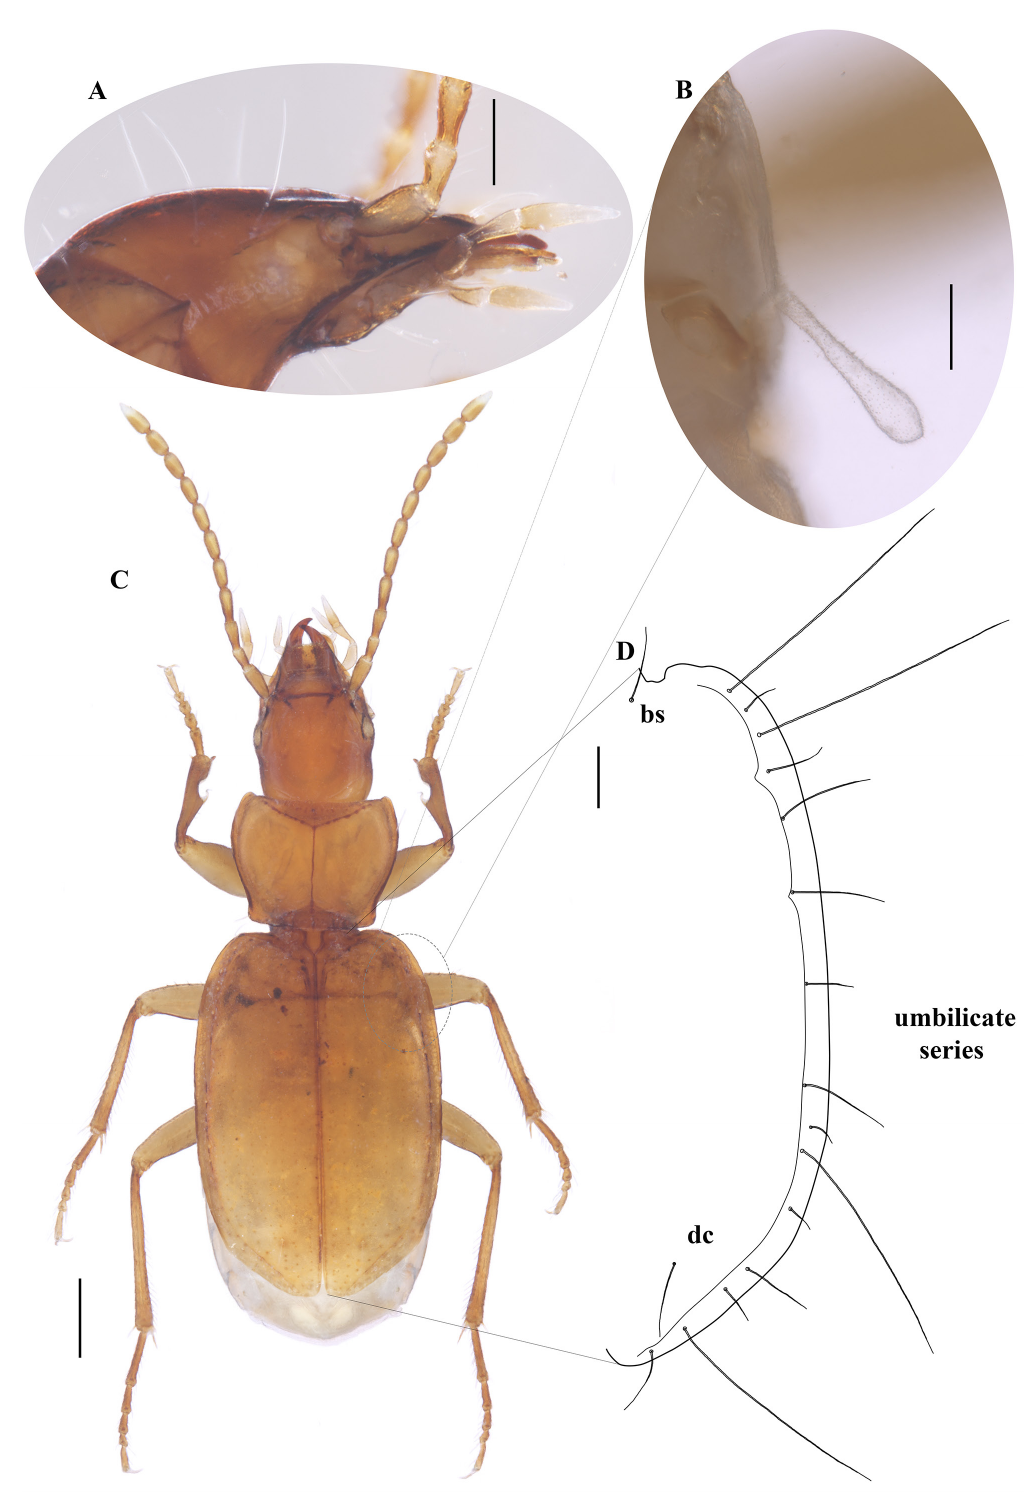
Fig. 1. Illustrations of Perigona ( Neoperigona ) spelunca sp. nov. (ISLA 66143) A . Eye detail, lateral view. B . Hindwing detail, dorsal view. C . Habitus, dorsal view. D . Detailed (bs) elytral basal/scutellar seta, (dc) elytral aplical discal seta of the 4 th and 5 th striae joint and umbilicate setae series elytral 8 th stria. Scale bars: A, D = 0.2 mm; B = 0.1 mm; C = 0.5